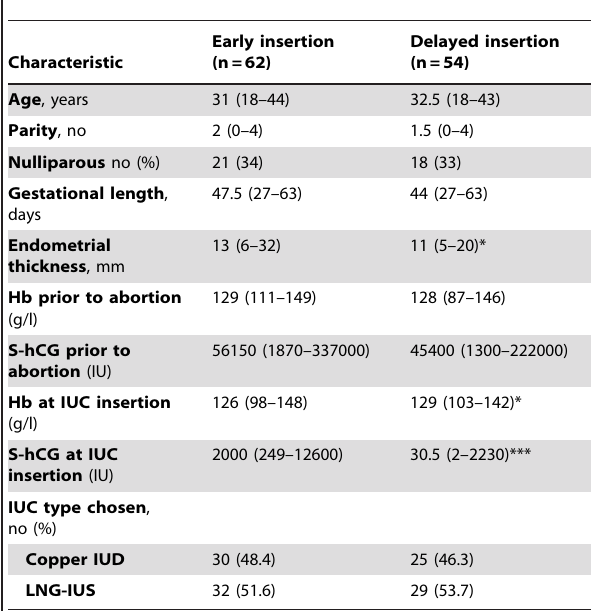
Table 1. Demographic characteristics of women randomized to Early versus Delayed insertion of an IUC post medical abortion.